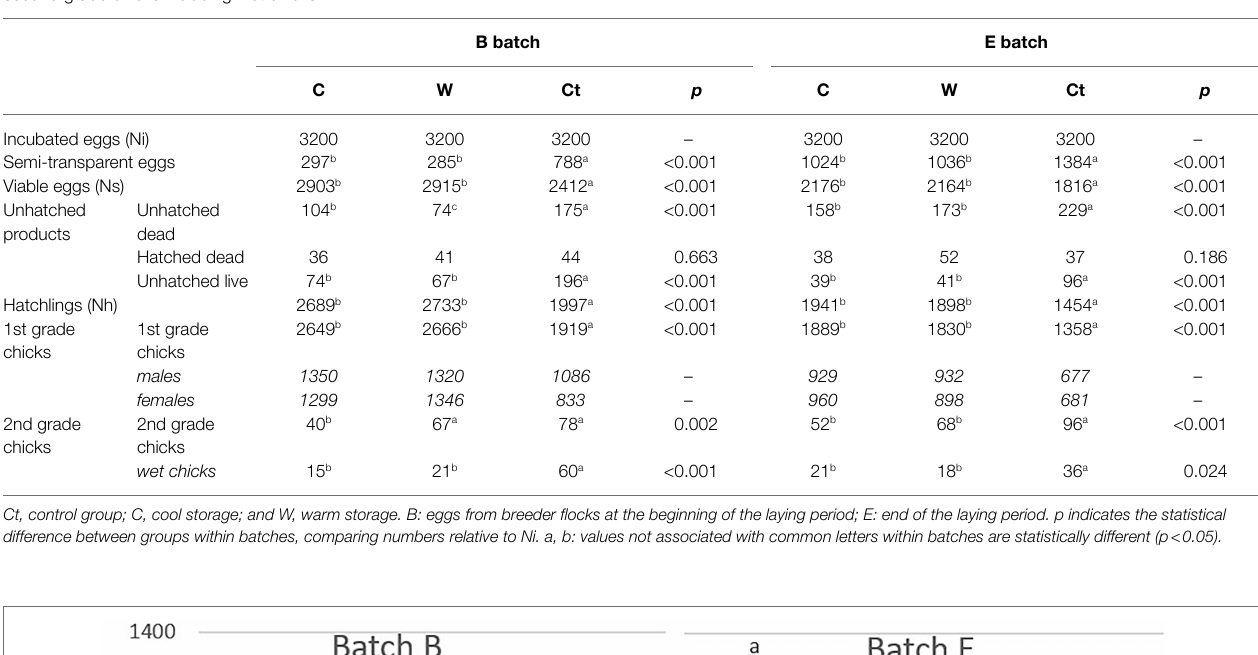
TABLE 2 | Number of incubated eggs (Ni), semi-transparent eggs eliminated at ED18, eggs kept in the incubator after the candling process (Ns), unhatched products—detailed as unhatched dead in shell embryos, hatched dead chicks and unhatched live in shell chicks; number of hatched chicks (Nh)—detailed as first and second grade chicks including wet chicks.